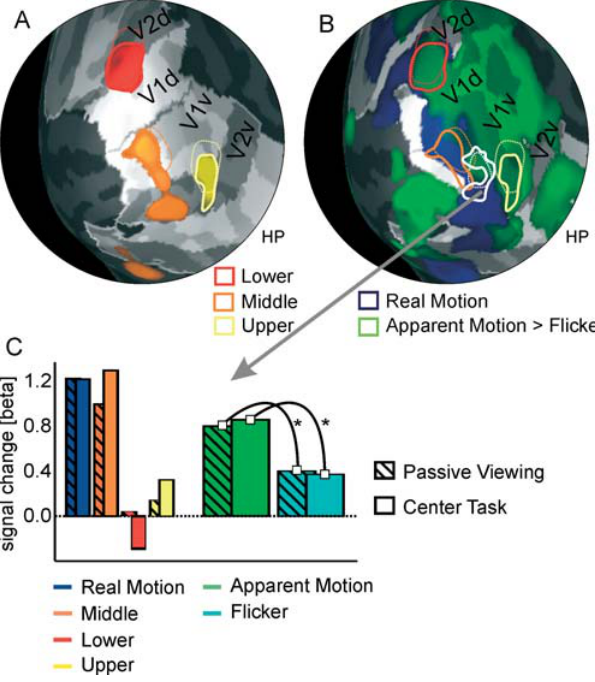
Figure 3. Cortical Activation in V1 for Experiment 2 (A) Left occipital cortex of subject HP (all five subjects are shown in Figure S2) with superimposed contrast maps indicating the cortical representation of the stimulus positions: upper (yellow), t (1445) . 15; middle (orange), t (1445) . 12; and lower (red), t (1445) . 9.3 (all p ,, 0.001). For comparison, the patches from experiment 1 (see Figure 1) are marked with dotted lines. (B) Cortical activation maps for apparent motion (green) and real motion (blue). In this case, apparent motion is contrasted with the flicker control condition (apparent motion . flicker in V1: t [1445] . 3.6, p , 0.0004); real motion is compared to fixation baseline (real motion . baseline in V1: t [1445] . 18.6, p ,, 0.001). The white line indicates an example of a significant ( t . 2.2, p , 0.05) contrast conjunction: (middle . upper) and (middle . lower) and (apparent motion . flicker). (C) BOLD activity profile of the region indicated by the white line in (B). Bars indicate average activity during the respective conditions expressed in beta weights from a GLM analysis. DOI: 10.1371/journal.pbio.0030265.g003 of the apparent-motion path by use of the middle mapping condition (conjunction map: middle . upper and middle .